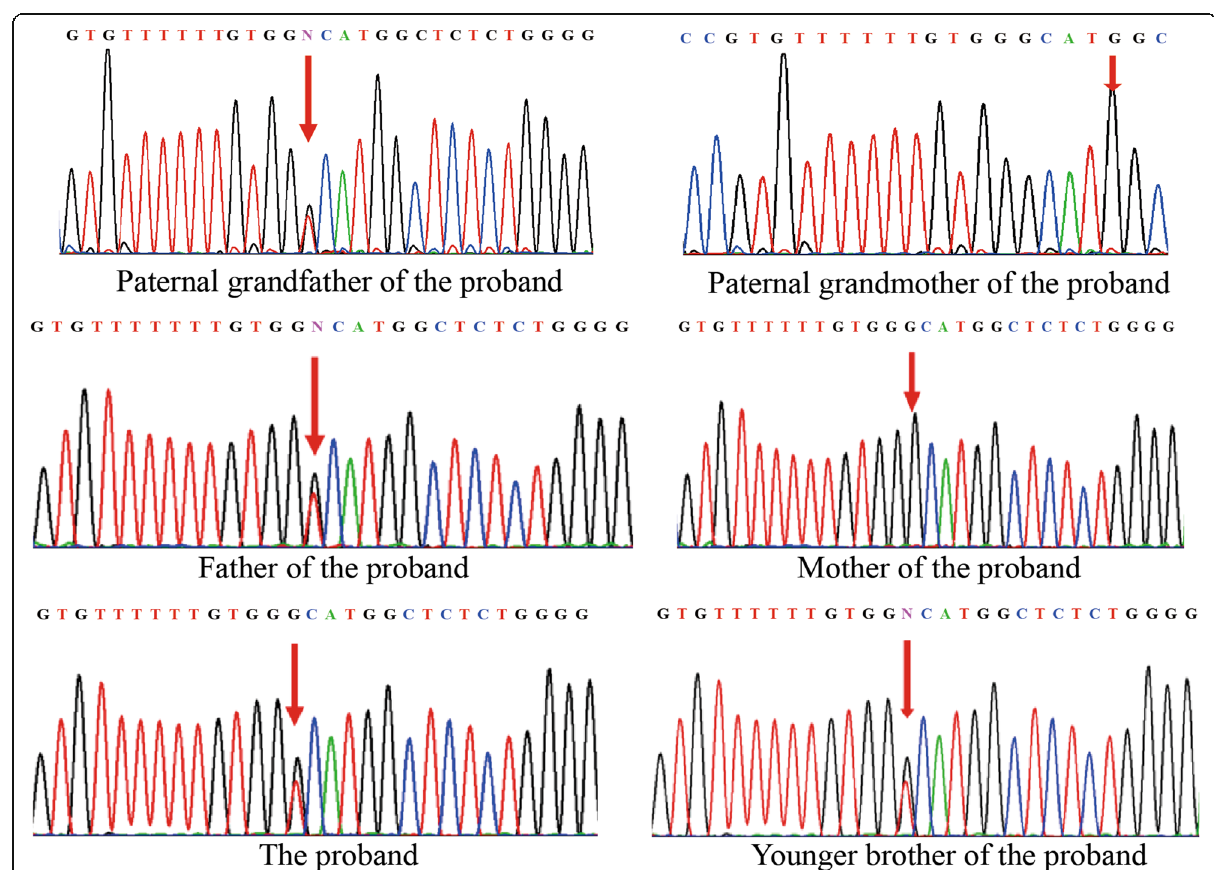
Fig. 4 Sequence chromatograms of the TSC2 gene. A same heterozygous TSC2 variant c.899G > T (arrow) is identified in the proband, her younger brother, father and paternal